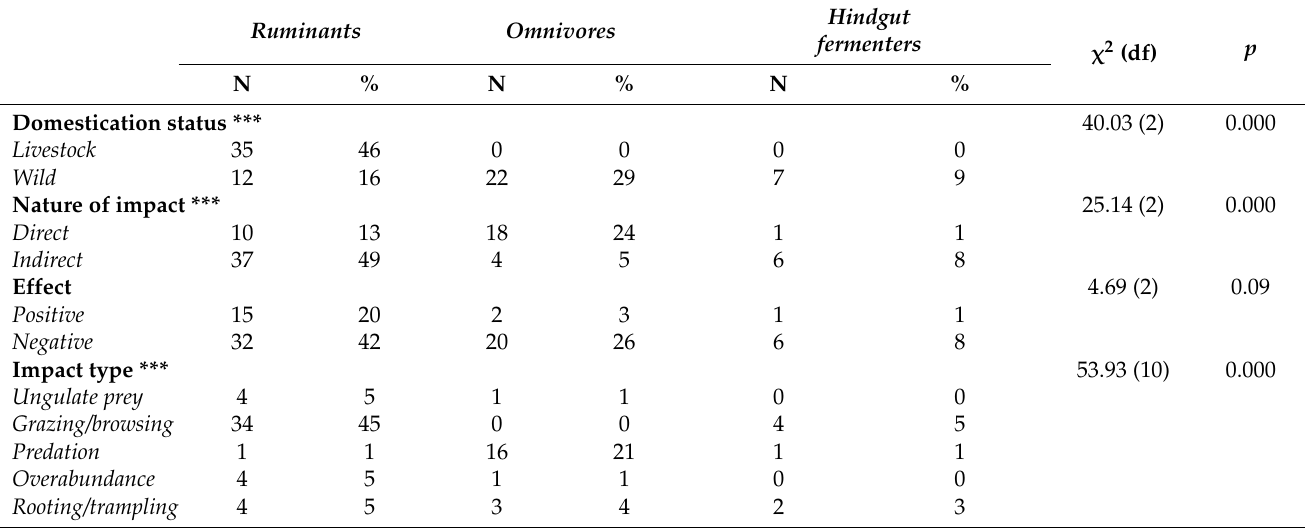
Table 3. The results of Pearson’s Chi-square tests with Yates continuity correction on ungulate-reptile interactions grouped by the digestive system and foraging characteristics of ungulates (i.e., foregut fermenter herbivores (Ruminants); hindgut fermenter herbivores and monogastric Omnivores). *** p < 0.001.